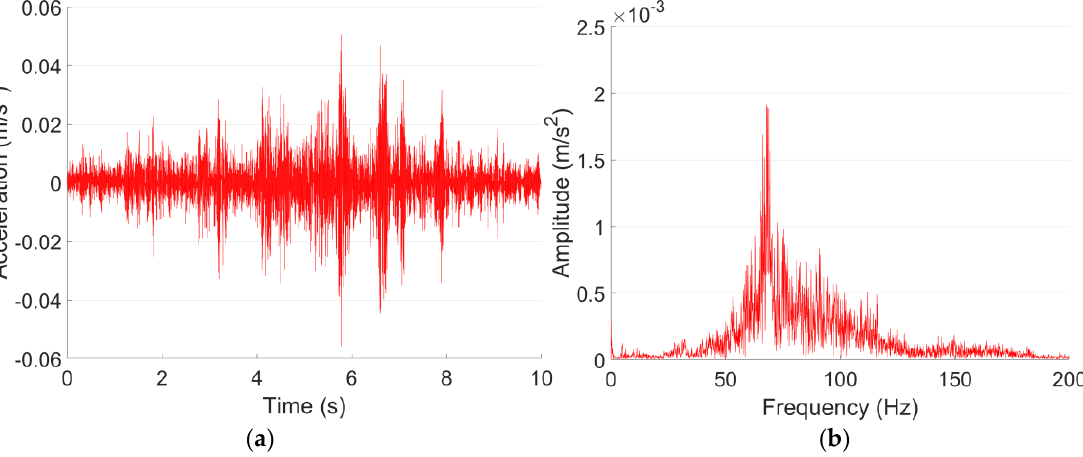
Figure 14. Typical acceleration responses in time ( a ) and frequency ( b ) domain in P1 in the site of the theater.